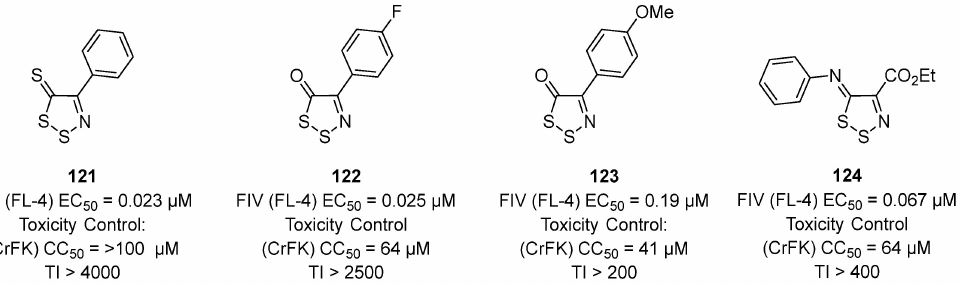
Figure 21. Summary of the initial report of antiviral activity of the 1,2,3-dithiazole scaffold.